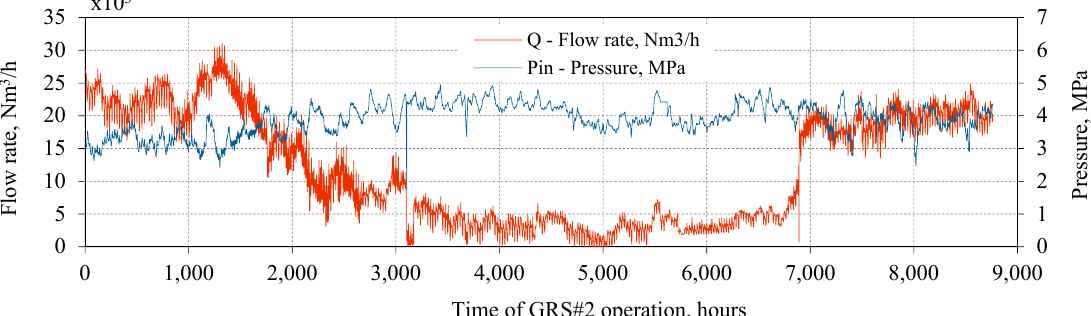
Figure 6. Natural gas flow and pressure at regulation stations GRS #3 (before expansion) over a period of one year. Figure 7. Natural gas flow and at pressure regulation stations GRS #5 (before expansion) over a period of one year. The annual fluctuations in the GRS # 1 work parameters, presented in Figure 4, are the smallest among those presented. It is seen that in the summer months the daily irregularity of gas consumption during weekends decreases. The decrease in gas flow presented in Figure 4 is larger than presented in Figure 3 but not as drastic as in the case of GRS # 3 (operation profile is shown in Figure 5). In the range of 5000–6800 h, GRS # 3 almost doesn’t function, and the expansion device does not produce electricity. The lack of gas flow through the station negatively affects the economic effect of the expander as the investment costs incurred for the purchase and installation of the expander device are not recovered. The performance profile of GRS #5 presented in Figure 6, differs significantly from the GRSs discussed above. In this case, a significant increase in gas flow occurs in the range of 3800–5600 h, after which a significant reduction in gas flow is observed. The presented performance profile indicates that GRS #5 is one of the natural gas supply stations which provide gas to a ring-shaped gas distribution pipeline network in a large city. For the range of 3800–5600 h, all or almost all of the city's